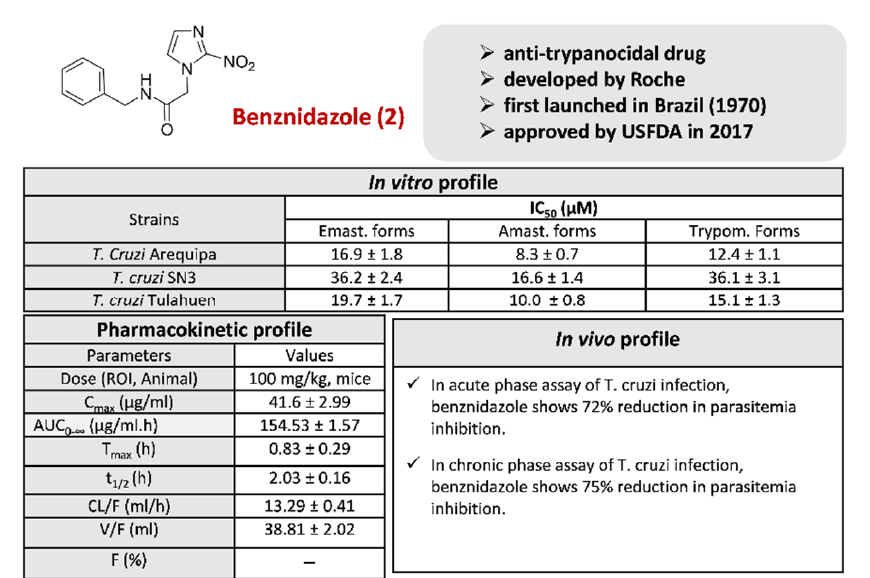
Figure 5. Activity profile of Benznidazole 2 .